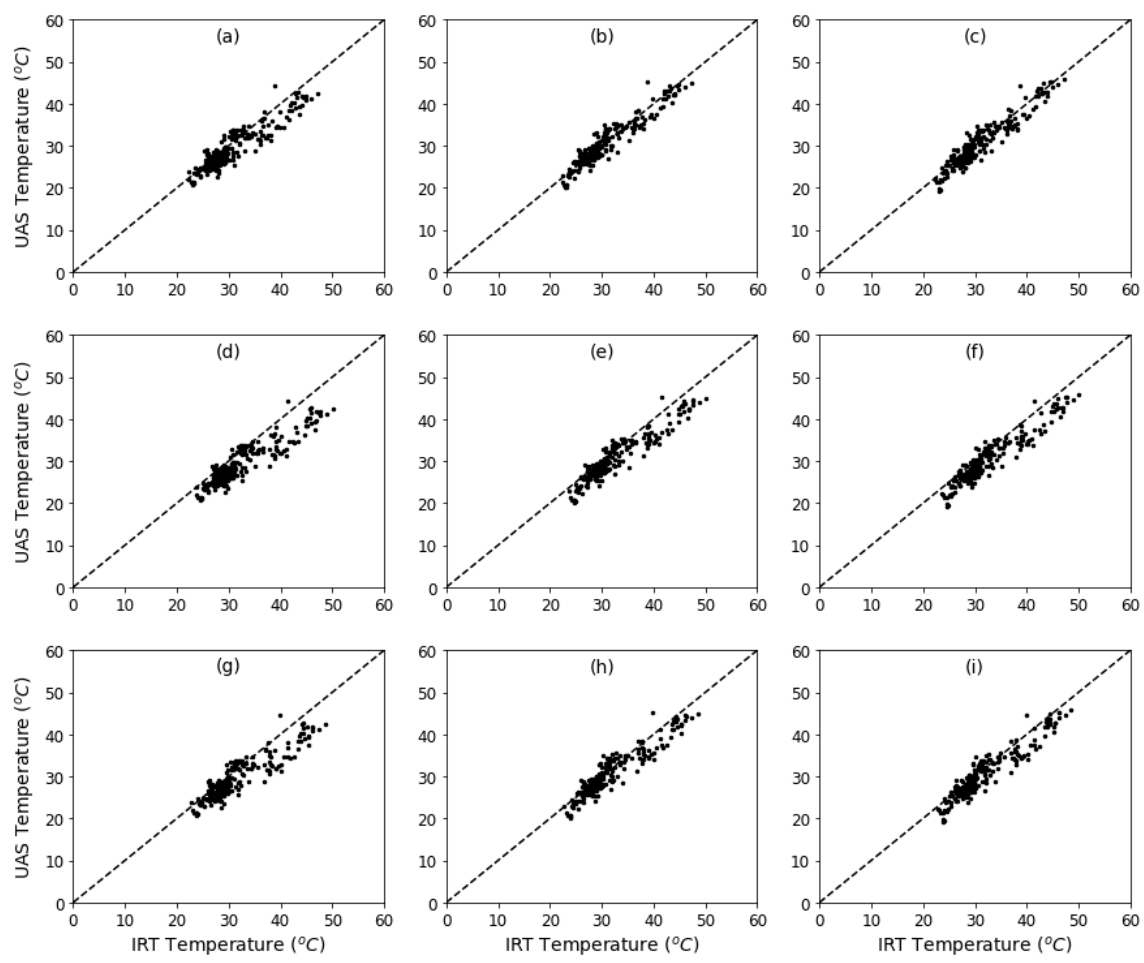
Figure 3. Comparison of surface temperature measurements from UAS FDPR thermal camera and field IRTs at different